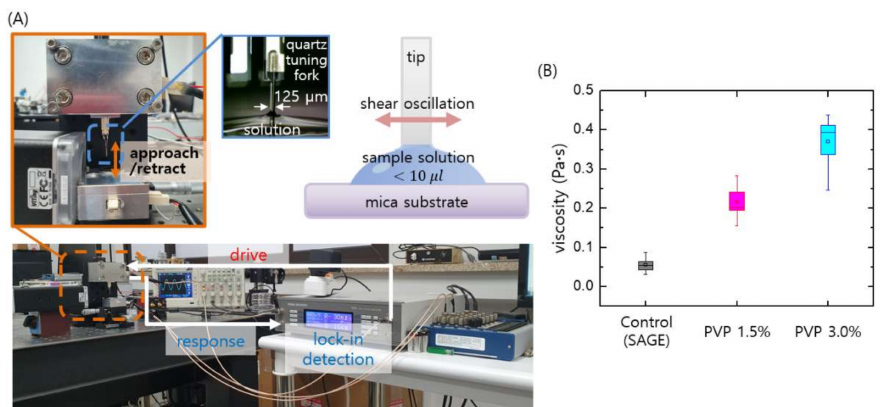
Figure 2. Micro-viscometry of the media used in the microfluidic SSC. ( A ) A home-built micro- viscometer is used to quantitatively measure the media viscosities, which are controlled by changing the mixing ratios of SAGE (sperm washing solution) and PVP. The tip shearing the fluid is harmoni- cally driven, and its response is detected by the lock-in technique to measure the amplitude and phase of the tip oscillation. From the information of oscillation amplitude and phase shift of the shearing tip, the interaction force with the fluid and thus the fluid viscosity is quantitatively determined. ( B ) Three media solutions were prepared, namely the base solution (SAGE, the control) with a viscosity of about 0.07 Pa · s and two PVP solutions (1.5% and 3%) with relatively high viscosities in the range of 0.2–0.4 Pa · s, as measured using the micro-viscometer.